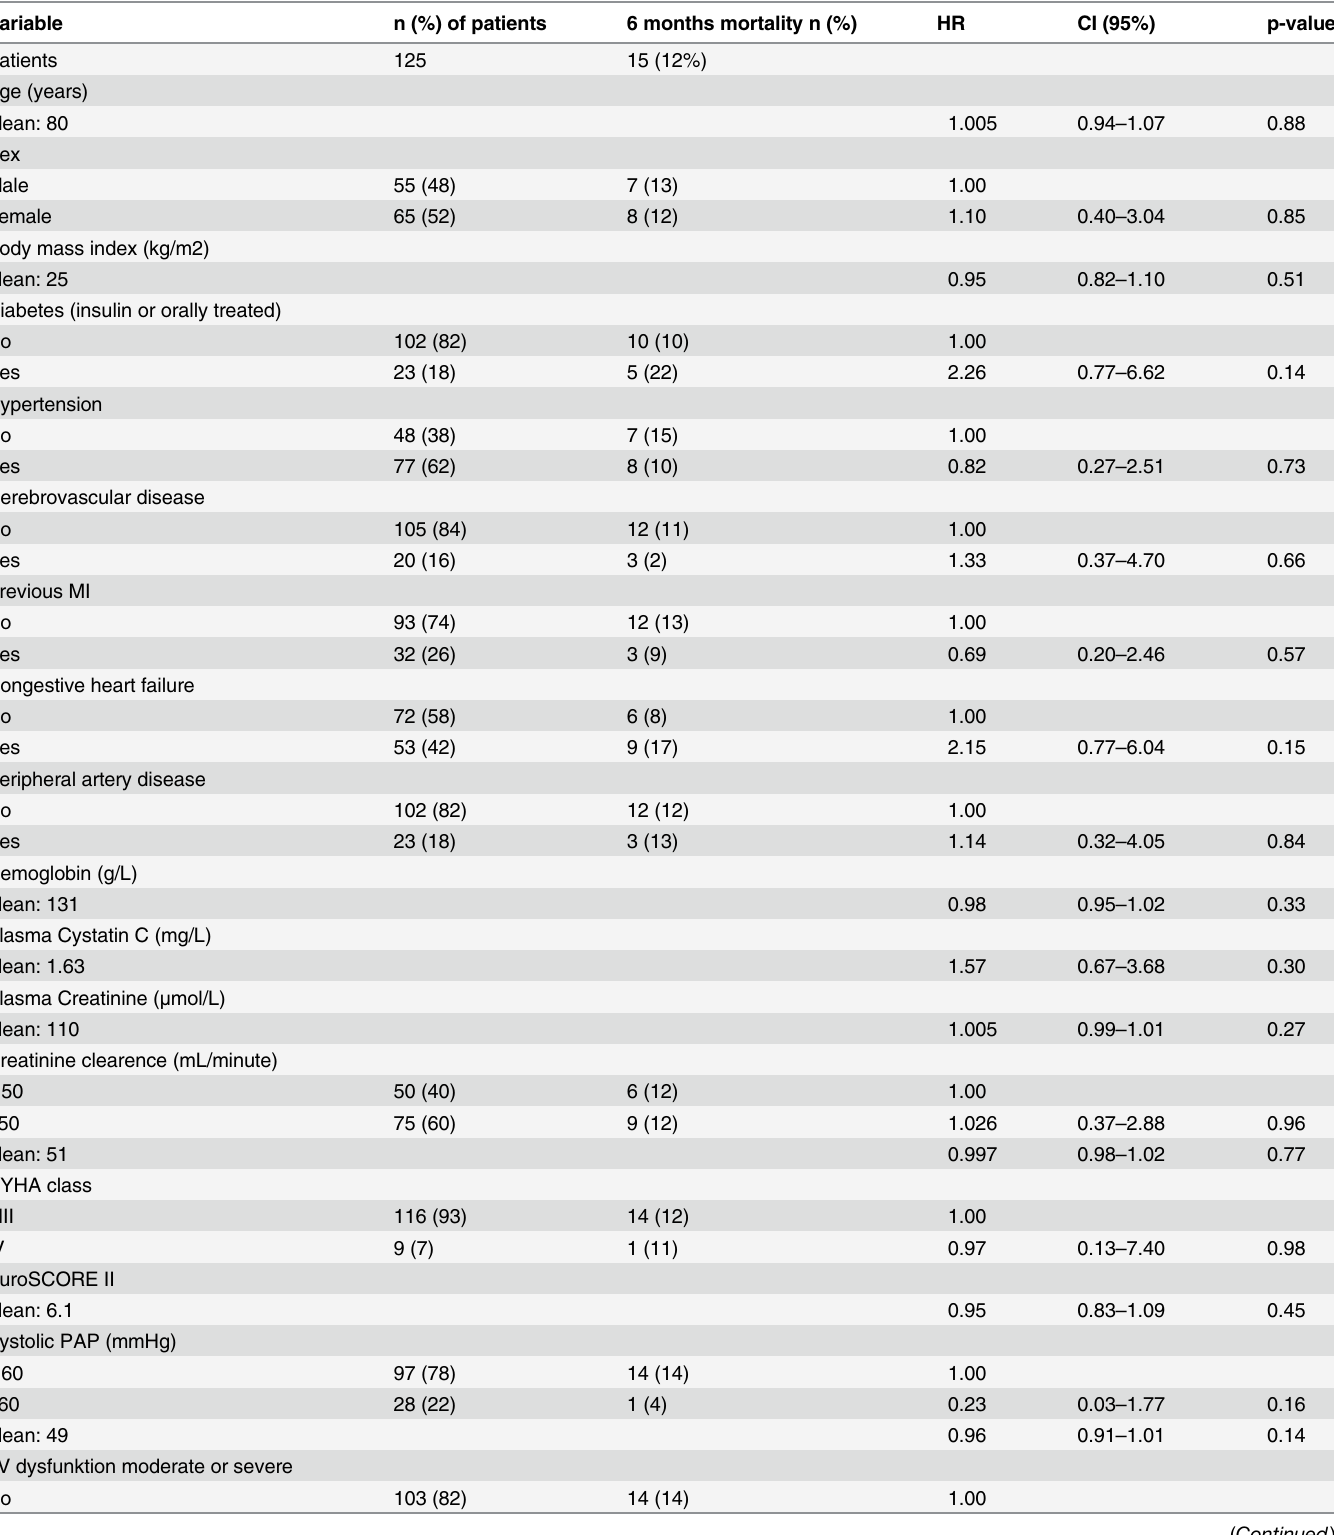
Table 6. Univariate Cox regression analysis of risk factors for 6-months cumulative